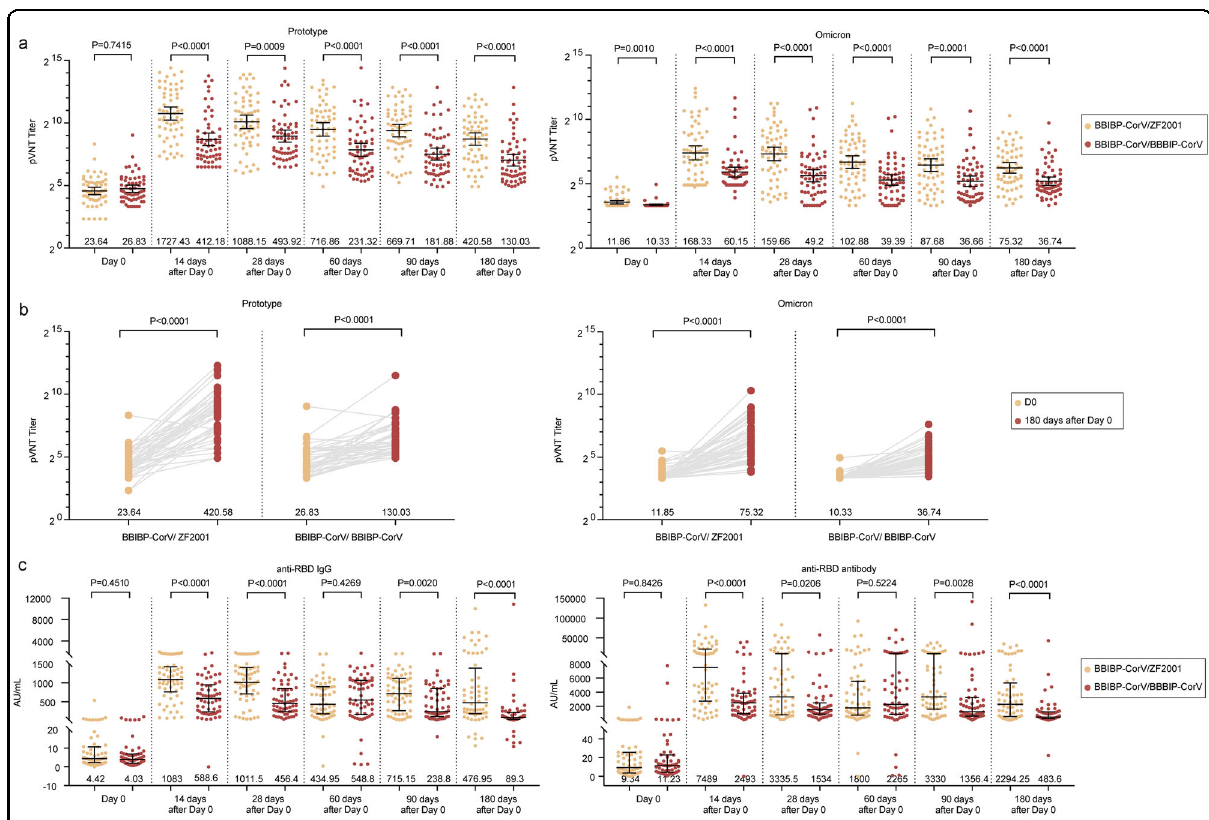
Fig. 1 Longitudinal dynamics of neutralizing antibody responses induced by the booster vaccines. a Neutralizing antibody titers after the third-dose vaccination against the prototype (left) or Omicron variant (right) evaluated by pVNT. The horizontal bars indicate the GMT, and error bars indicate the 95% con fi dence interval. b Neutralizing antibody titers against the prototype (left) or Omicron variant (right) in BBIBP-CorV/ZF2001 heterologous booster group and BBIBP-CorV/BBIBP-CorV homologous booster group. Neutralizing antibody titer against the Omicron variant in BBIBP-CorV/ZF2001 heterologous booster group and BBIBP-CorV/BBIBP-CorV homologous booster group. c Concentrations of anti-RBD IgG (left) or anti-RBD antibody (right) against the prototype after the third-dose vaccination. The horizontal bars indicate the median concentration, and error bars indicate the inter-quartile